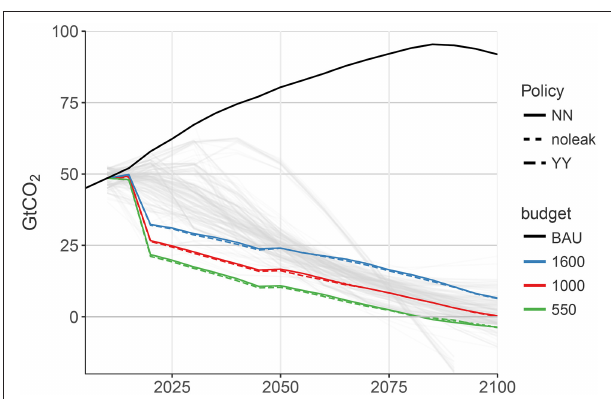
FIGURE 1 | Global greenhouse gas emissions ( GtCO 2 eq ) across scenarios. For target different from BAU, leakage is set to 0 or 0.1 % / year . In gray are plotted the scenarios form the AR5 Scenario Database in line with the 2 ◦